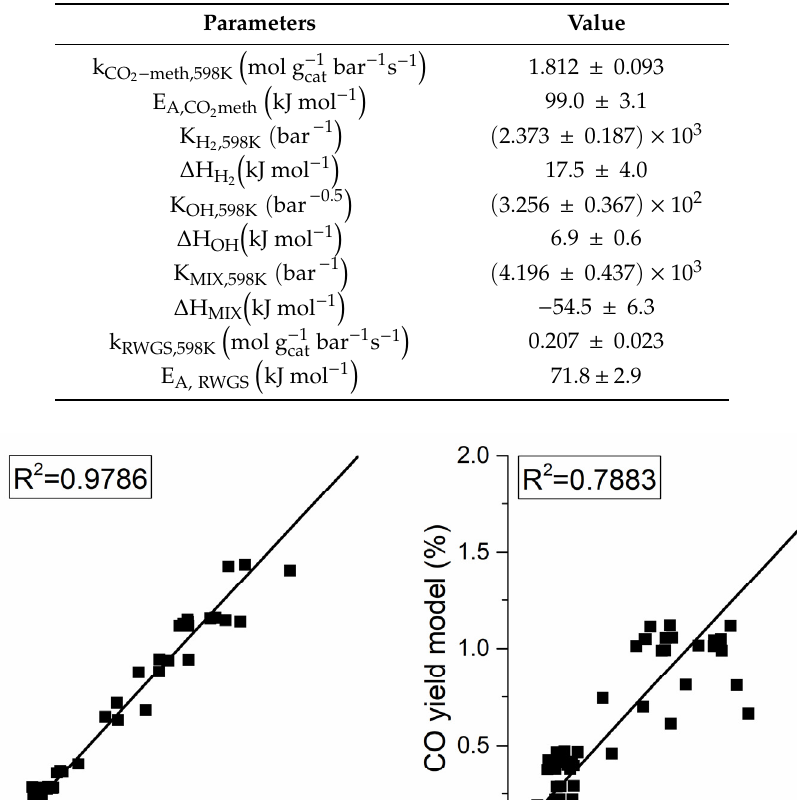
Table 6. Langmuir-Hinshelwood-Hougen-Watson (LHHW) kinetic parameters.